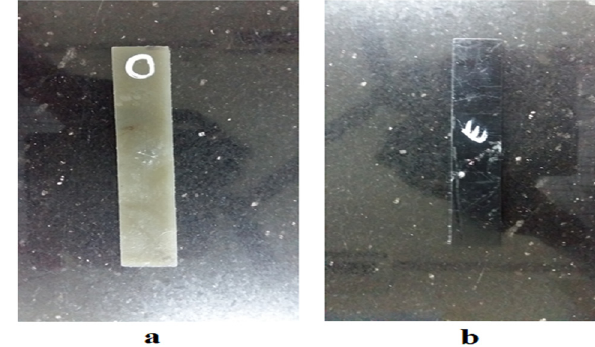
Figure 7: ( a – b ) : Dumb - bell shaped tensile strength testing specimens. Figure 8: ( a – b ) : Compressive strength testing specimens.